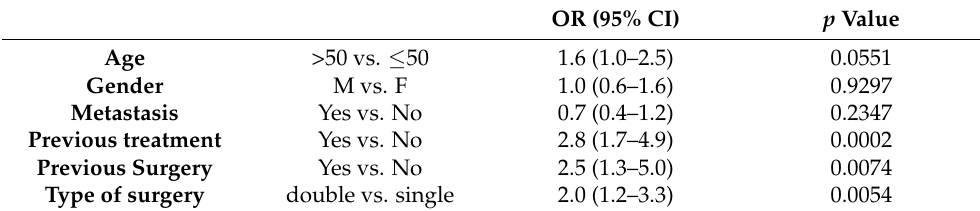
Table 8. Results from univariate Logistic models for Complication.